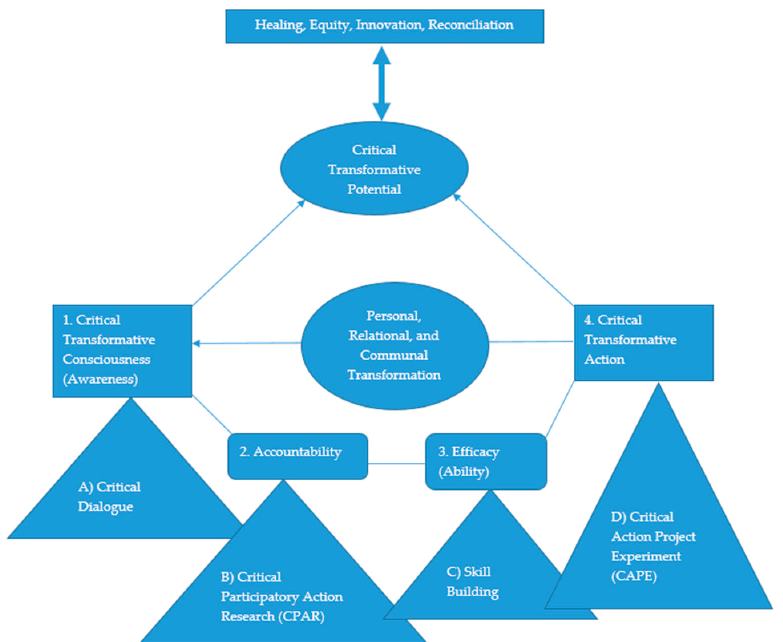
Figure 5. The InTrePID Method to Develop Critical Transformative Potential for Healing, Equity, Innovation and Reconciliation. Note. Figure 5 depicts the full theoretical model consisting of Critical Transformative Potential, the Critical Transformative Potential Development Framework (numbers 1–4) with the components of the InTrePID method (letters A–D) theorized to promote personal, relational, and communal transformation for healing, equity, innovation, and reconciliation (Bussey et al.